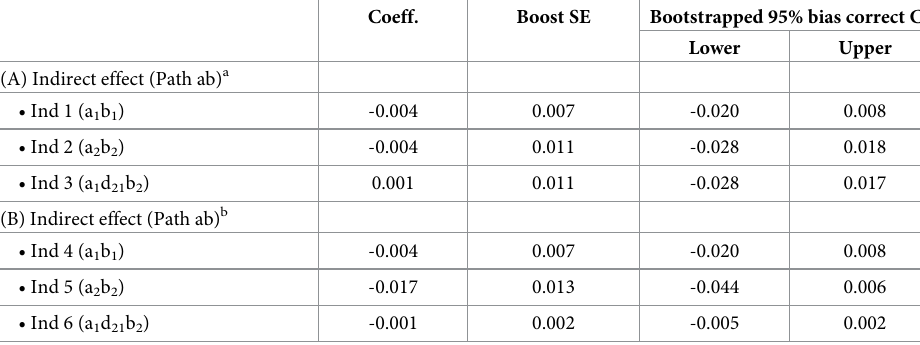
Table 2. Indirect associations between height and the risk of GDM by mediators.